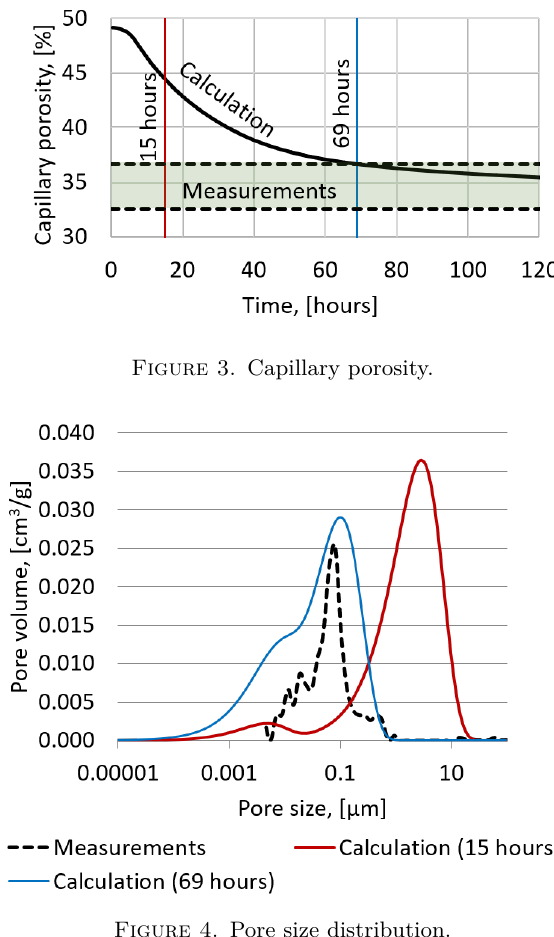
Figure 4. Pore size